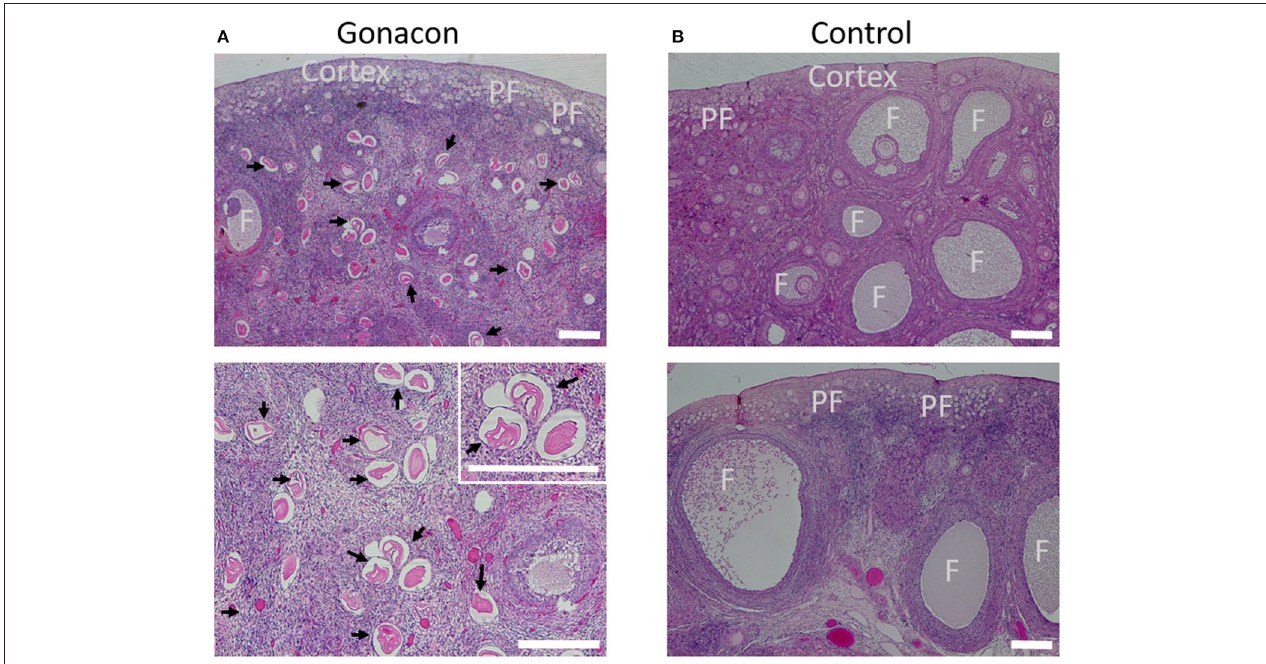
FIGURE 9 | Histology of ovaries of Gonacon-vaccinated cats. Representative ovaries of Gonacon-vaccinated cats (A) are shown, as compared to ovaries of non-vaccinated cats (B) . Note the large number of degenerative oocytes (black arrows) in the ovaries of Gonacon-vaccinated cats. PF, crowded primordial follicles under the ovary’s tunica albuginea, at the ovarian cortex; F, antral follicles. H&E staining. Scale bars in all images are 30 µ